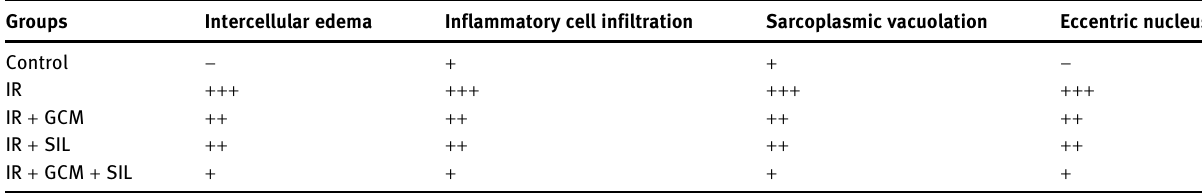
N=  in each group. ( − ): normal, ( + ): mild change, ( ++ ): moderate change, ( +++ ): severe change. IR, ischemia-reperfusion; GCM, ginsenoside compound-Mc  ; SIL,